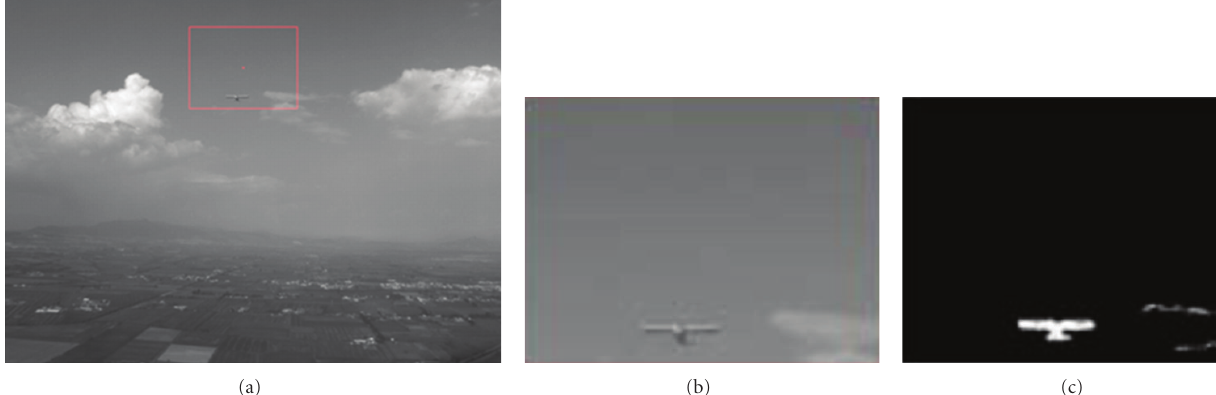
Figure 3: (a) Flight image with the search window centered on input radar-based tracking estimates; (b) processed image; (c) edge detection- labeling algorithm output.